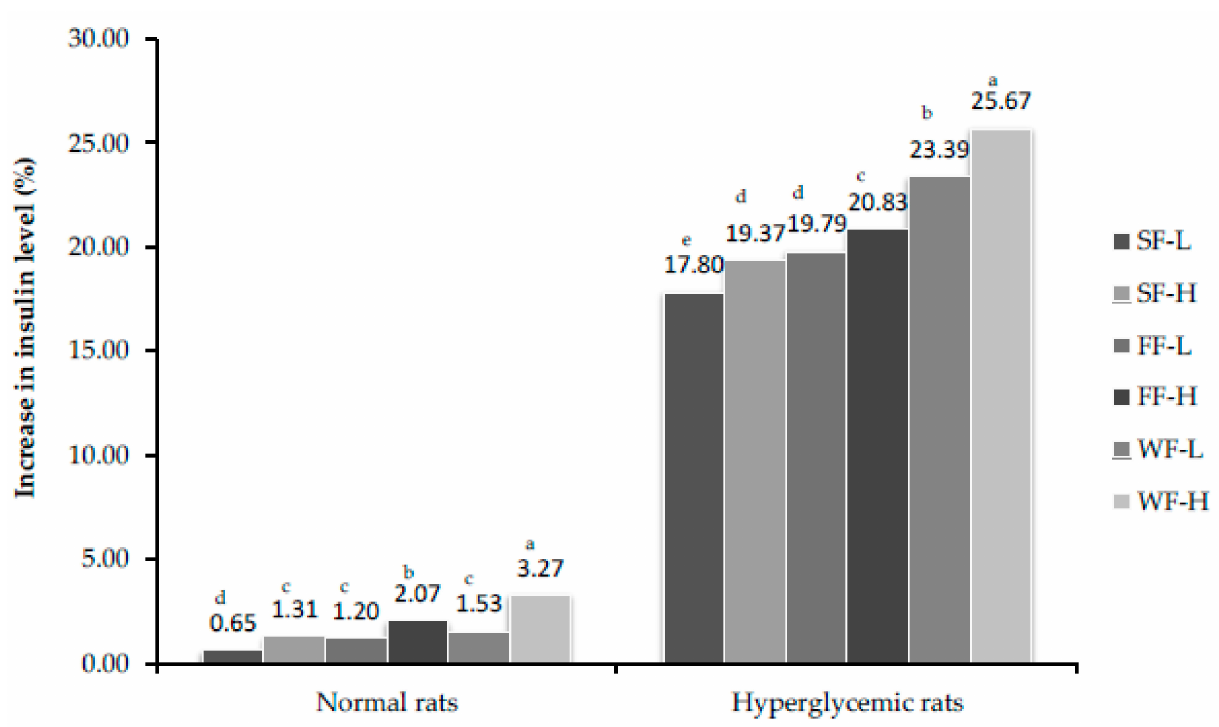
Figure 4. Percent increase in insulin level after feeding bitter gourd on 28th day. Bars that do not share similar letters denote statistical significance ( p < 0.05).